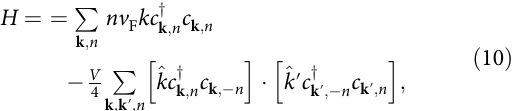
Fig. 3 for different values of β , i.e., β = 0, β = π /2, β = π , β = 3 π